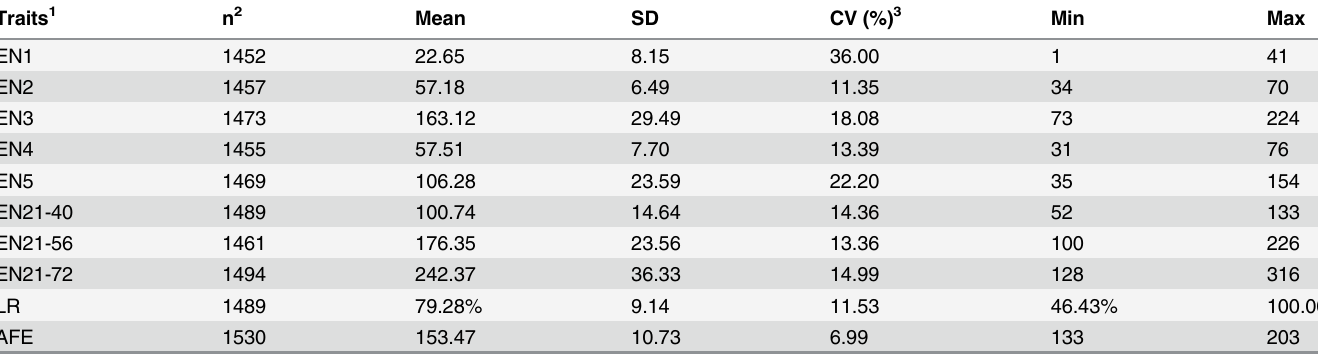
Table 2. Descriptive statistics of egg production traits for F 2 chickens. Traits 1